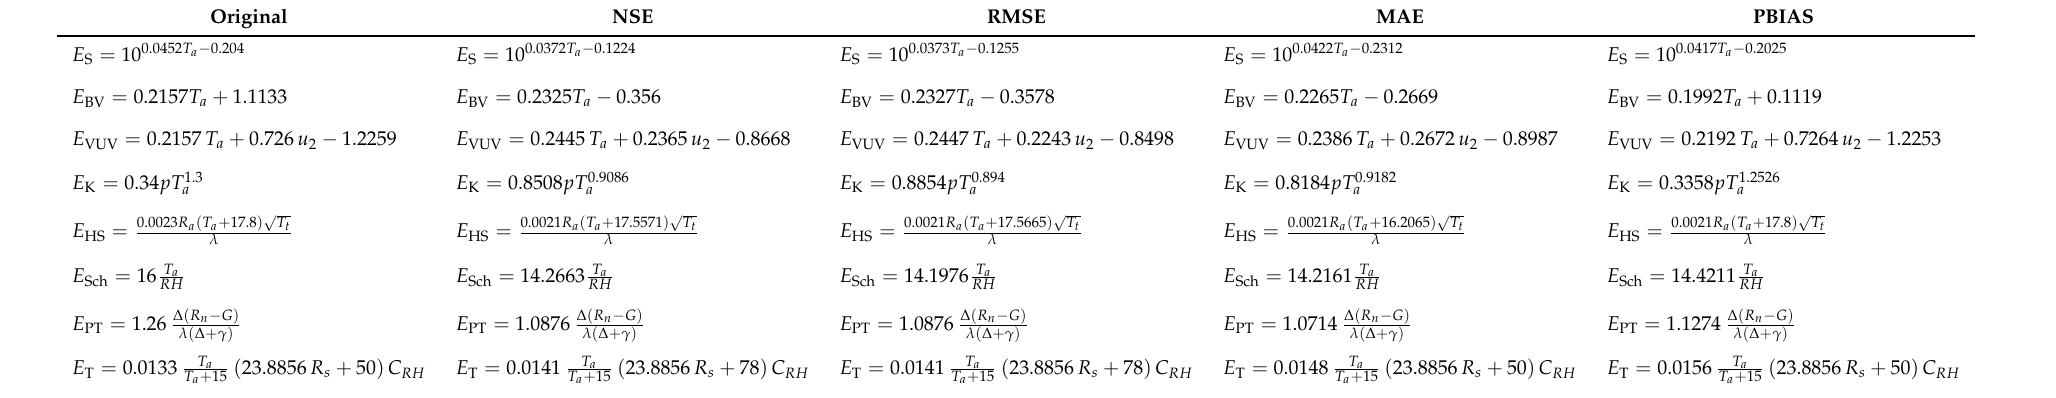
Table 2. The comparison of original and calibrated models. The calibrated models have been obtained as a mean value of the cross-validation process. The presented models have the values of statistical measures corresponding to Table 1. Despite the theoretical equality of NSE and RMSE optimal parameters (see Theorem 1), the numerical algorithm provides slightly different